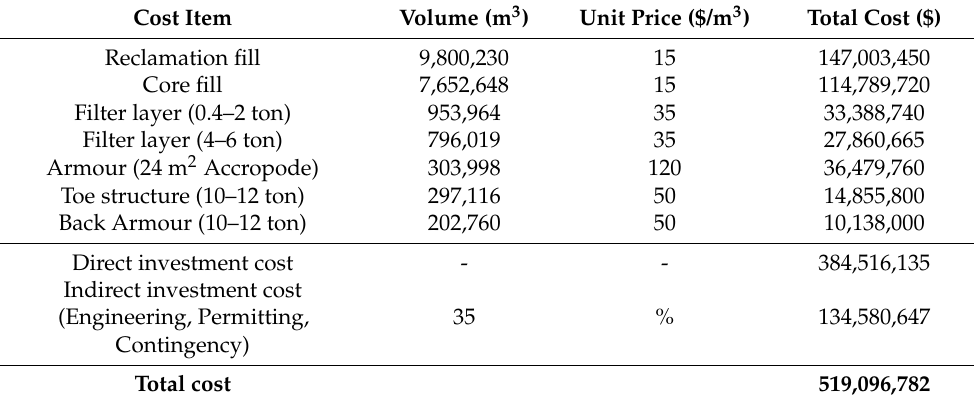
Table 5. Cost estimate for the artificial island—Alternative No.